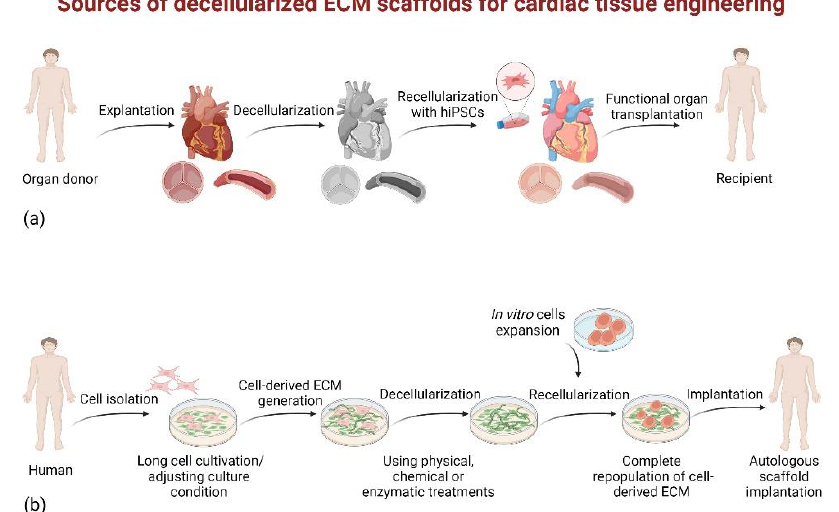
Figure 2. Classification of dECM scaffolds. ( a ) Native tissue-derived dECM scaffolds for tissue engineering. The organ (e.g., porcine heart, cadaveric heart) is harvested from the donor and undergoes the process of decellularization. This step involves the removal of the cellular components, leaving only the ECM, which maintains the organ’s composition, architecture, and mechanical properties. Then, the decellularized scaffold is repopulated with progenitor cells. The recellularized construct can be transplanted into patients after extensive evaluation of its functionality. ( b ) Cultured cell-derived dECM scaffolds for tissue engineering. Cells from different tissues innately generate matrices that mimic the relative composition of the natural tissue ECM. Once sufficient ECM has been deposited, the cellular component can be removed through a combination of decellularization treatments. Subsequently, cells from other sources are reseeded onto the dECM scaffolds to generate bioengineered grafts. Created with BioRender.com.